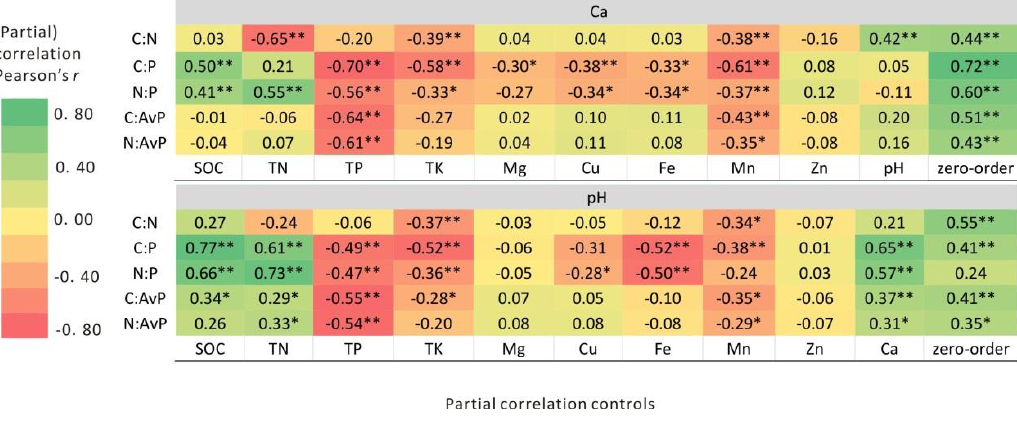
Figure 5. Partial correlation between C, N, and P stoichiometry and geochemical variables. 216 Significance levels are denoted as follows: *, p < 0.05; **, p < 0.01. 217